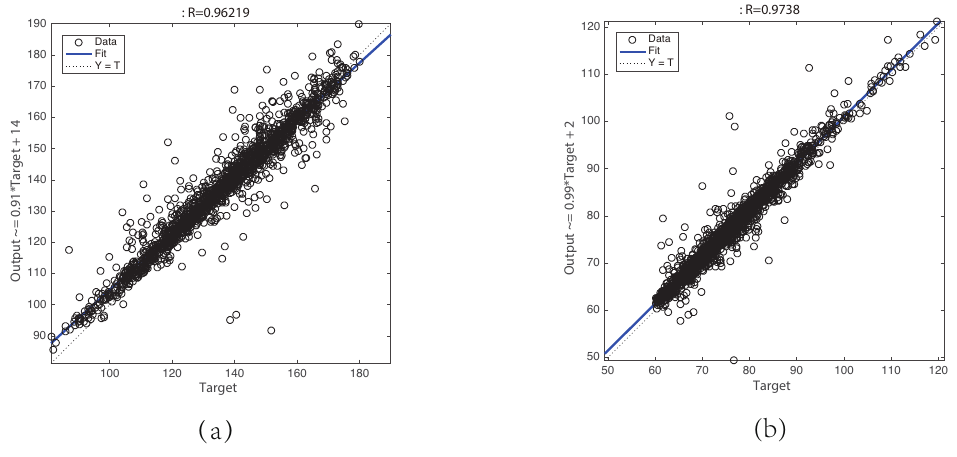
Figure 7. Linear regression plot of the ( a ) SBP and ( b ) DBP